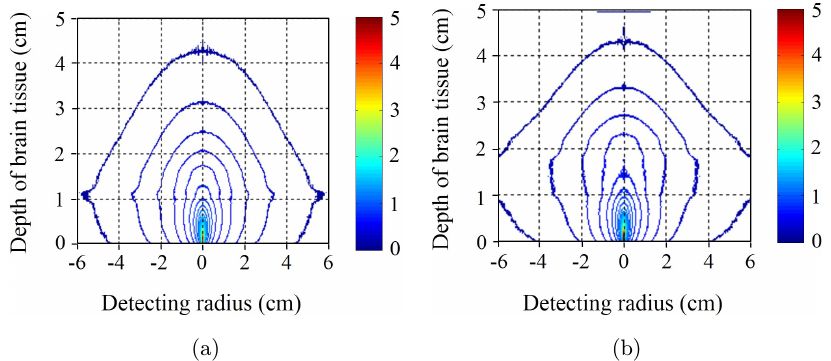
Fig. 6. Contour maps of the light intensity in the brain with di®erent thicknesses of CSF. (a) The thickness of CSF is 0.2 cm and (b) is 0.8 cm.